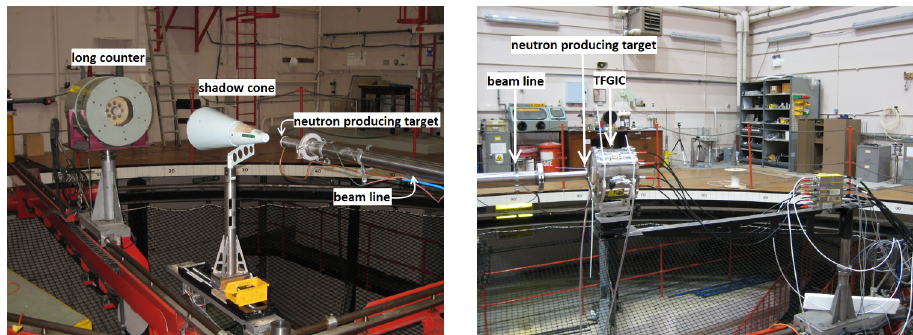
Figure 1. Left: NPL low-scatter area with the long counter and shadow cone aligned with the beam line. Right: TFGIC aligned with the beam line and neutron producing